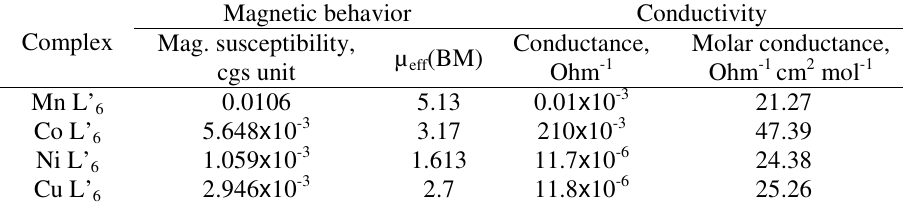
Table 2. Magnetic moment and